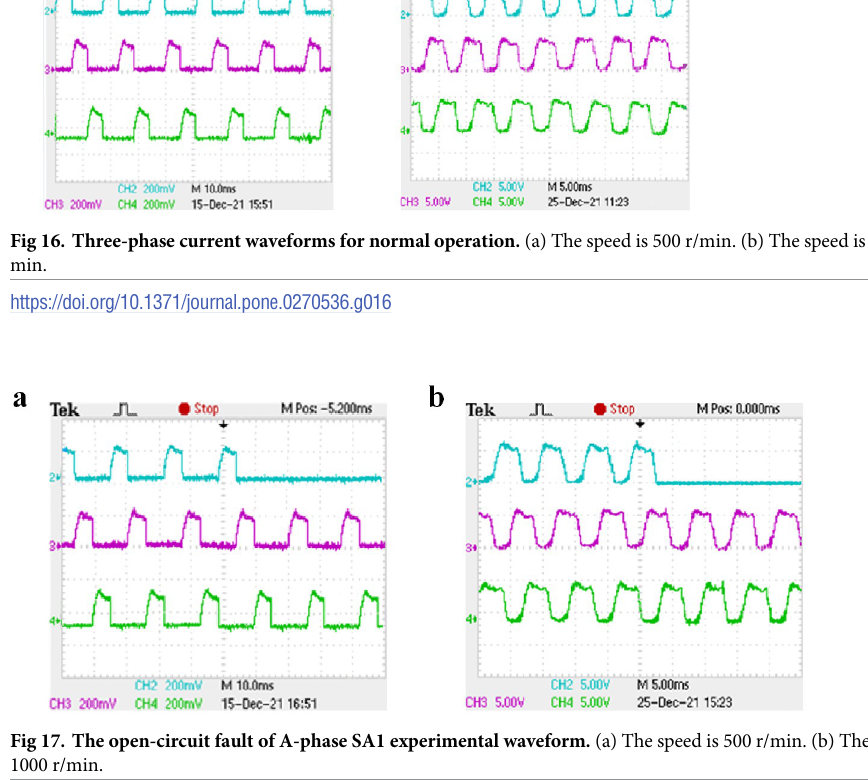
accurately locate the fault location.